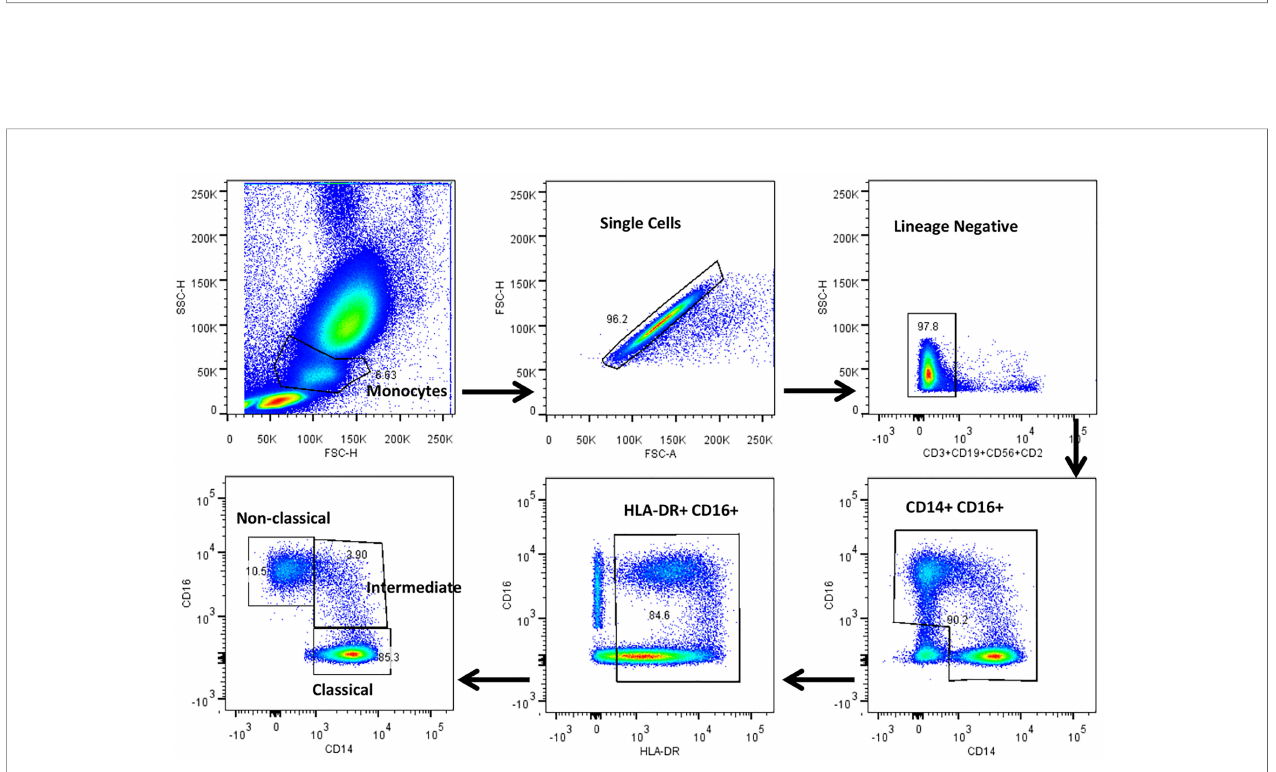
FIGURE 2 | Representative gating strategy for monocytes and their subsets. Monocyte populations were gated on whole blood cell plot by Forward (FSC-A) and Side scatter (SSC-A) based on their size and granularity. Singlets were discriminated against doublets by FSC (A) vs FSC (H). Dump gate were used to select lineage negative cells by excluding T cells, B cells and NK cells by CD2, CD3, CD19 and CD56 markers. Total monocytes were gated using CD14 and CD16 surface expression. HLA-DR+ and CD16+ cells were gated to obtain the pure monocyte population which were further gated using CD14 and CD16 surface markers to distinguish classical (HLADR + CD14 ++ CD16 - ), intermediate (HLADR + CD14 ++ CD16 + ) and non-classical (HLADR + CD14 +/- CD16 + )